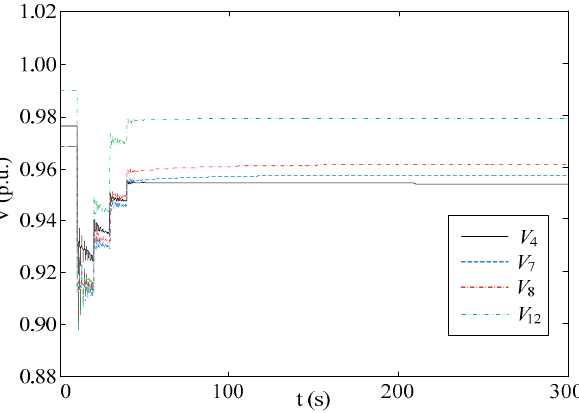
Table 3. Control actions in case B.